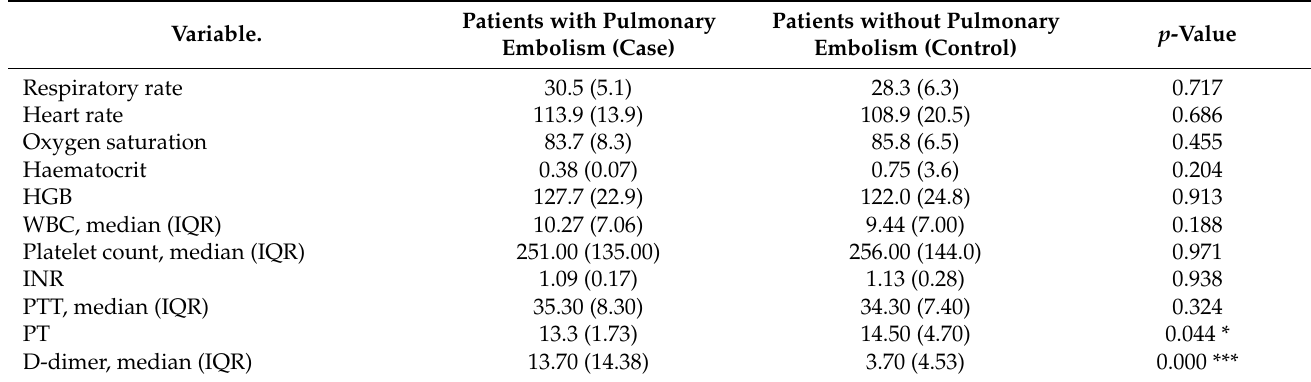
Table 2. Vital signs and blood tests upon admission.